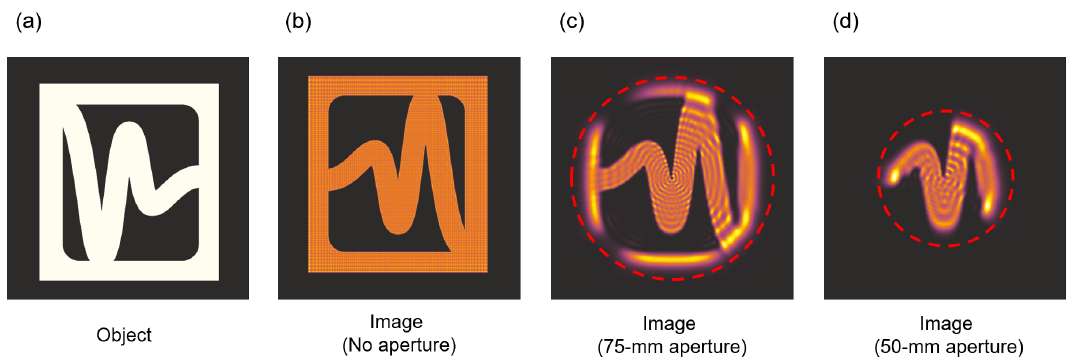
Figure 5. ( a ) The exemplary object used in simulations for 0.3 THz. ( b ) The image obtained in 4 f imaging setup assuming no aperture, only calculation matrix size. ( c ) The image obtained in 4 f imaging setup assuming lens apertures limited to 75 mm (marked with red dashed line) ( d ) The image obtained in 4 f imaging setup assuming lens apertures limited to 50 mm (marked with red dashed line). Formed images are inverted as in 4 f setups. The presented area corresponds to 90-mm-square area cut from 204.8-mm calculation